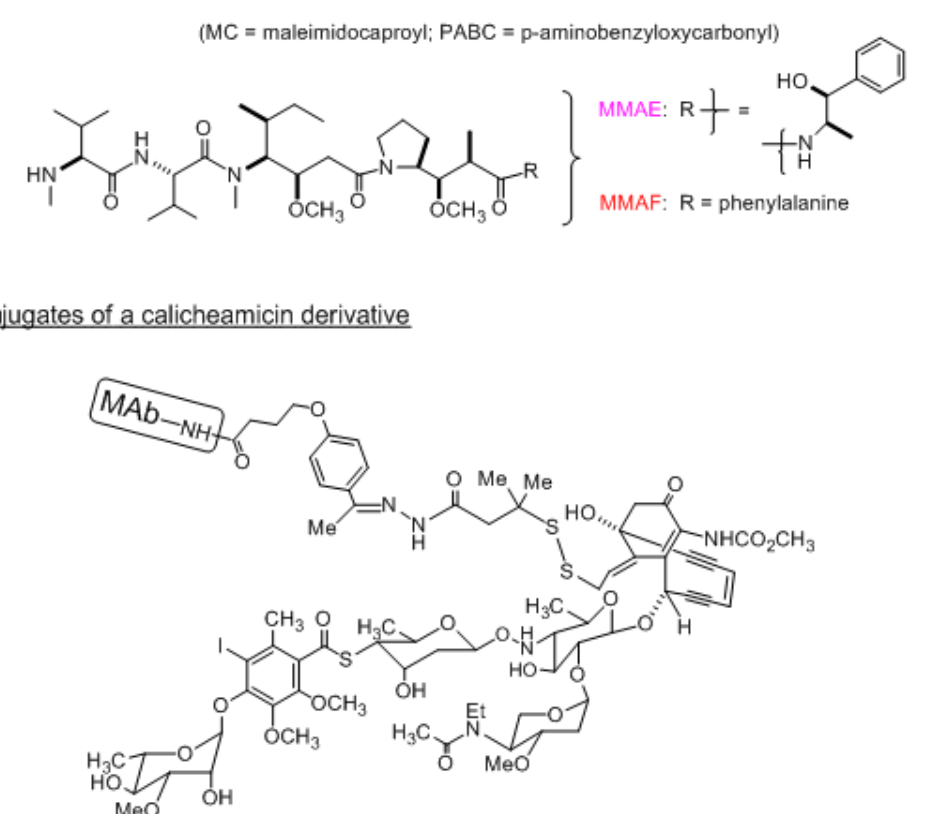
When compared to the clinical result with this drug conjugate, the outcome in the fractionated RAIT using 90 Y-epratuzumab in NHL patients (described earlier[17]) is quite favorable: 62% overall OR